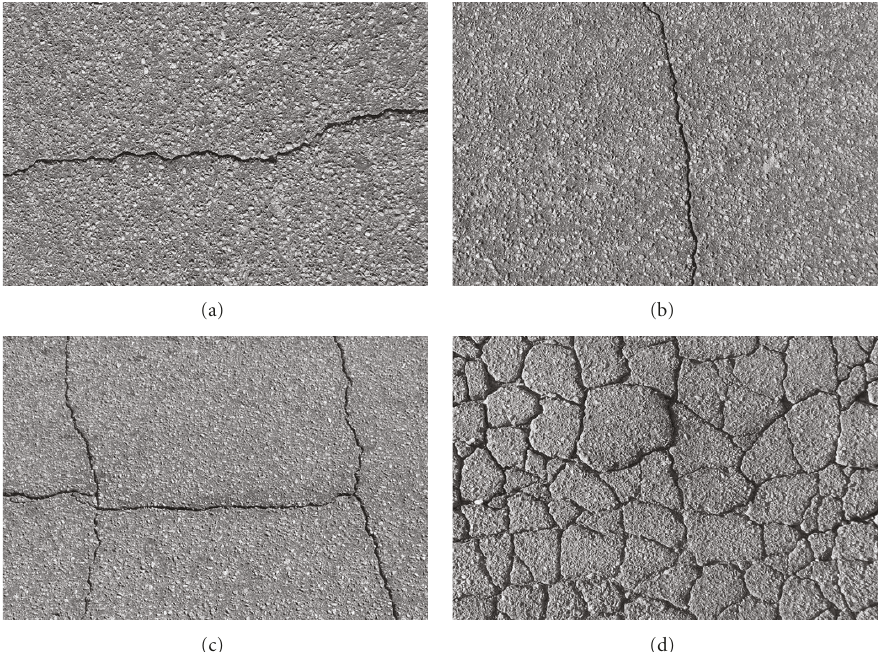
Figure 1: The four types of pavement cracks. (a) The transverse, (b) the longitudinal, (c) the block, and (d) the alligator.